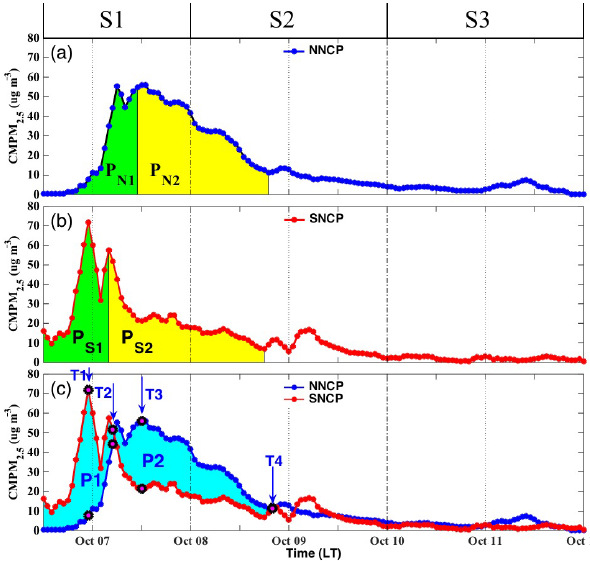
Figure 8. CFB contribution to PM 2 . 5 concentration (CPM 2 . 5 ) (a) in SNCP, (b) in NNCP and (c) their comparison. The key point-in- local-times of T1 (23:00, 6th), T2 (05:00, 7th), T3 (20:00, 7th) and T4 (19:00, 8th) are signed with blue